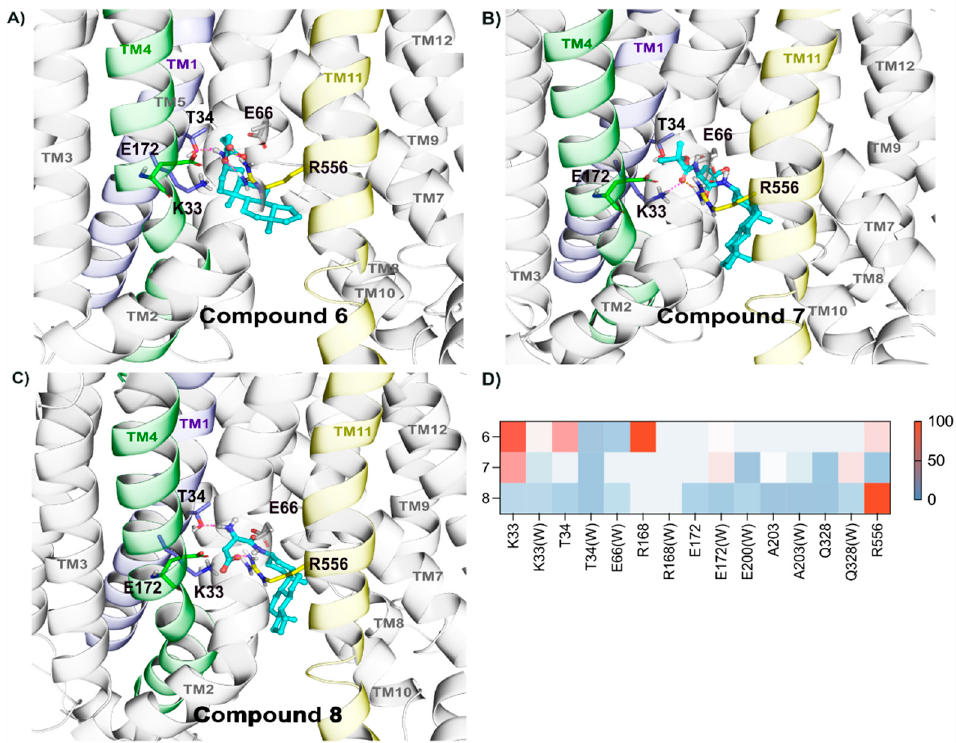
Figure 6. Stable binding mode of compounds 6 – 8 relies on polar contacts with Lys33, Arg168, and Arg556. Compounds 6 ( A ), 7 ( B ), and 8 ( C ) were docked and simulated within Site 2 of OATP1A2, and representative frames are depicted in ( A – C ), where one can observe the main residues with stable interactions in the simulations lying in the transmembrane helices 1 (highlighted in light purple), 4 (in green), and 11 (in yellow). ( D ) Individual residues and hydrogen bond interactions, and water interactions (represented as W), for each compound, are shown as heatmaps, where each interaction is colored according to the frequency.